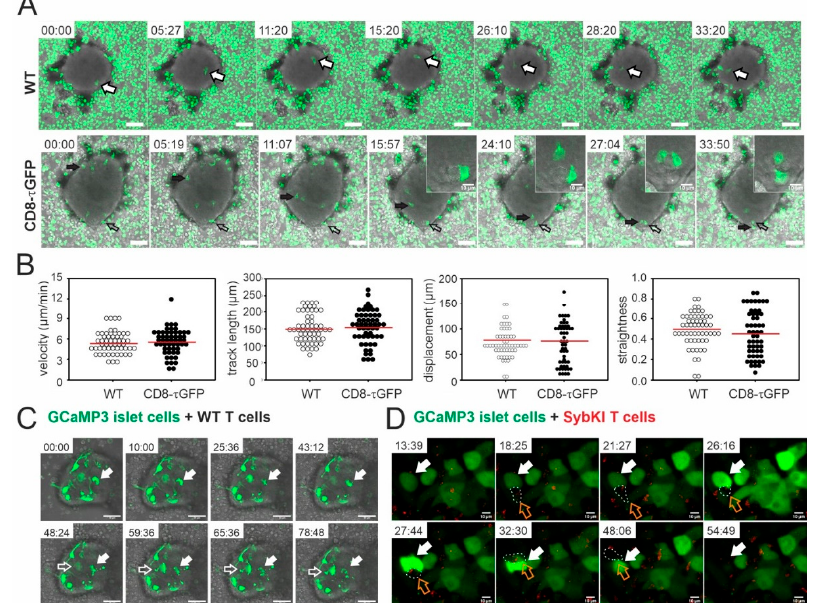
Figure 1. Confocal live imaging of CTLs infiltrating and killing pancreatic islet cells in vitro. ( A ) Confocal snapshots from live images of calcein-loaded WT and CD8- 𝜏 GFP CTLs (green) infiltrating an islet. Arrows point to individual CTLs. Scale bar: 50 µm. Inset shows a CTL (open arrow in overview) in contact with an islet cell. The images were acquired in 9 µm slices with 1 µm interval distance and ~0.3 Hz acquisition frequency. The entire recording is shown in Movies S1 and S2. ( B ) Quantitative analysis of velocity, track length, displacement and straightness of WT and CD8- 𝜏 GFP CTLs on DBA/2-derived islets of Langerhans. ( C ) Confocal snapshots from live images of WT CTLs co-cultured with islet cells which were infected with AV-GCaMP3 (green). Arrows point to apoptotic islet cells whose death can be followed in Movie S3. Scale bar: 50 µm. The images were acquired in 12 µm slices with 2 µm interval distance and ~0.2 Hz acquisition frequency. ( D ) Confocal snapshots from live images of SybKI CTLs (red) co-cultured with islet cells which were infected with AV-GCaMP3 (green). The white arrows point to an islet cell that showed a rapid increase in intracellular calcium concentration after contact with a single CTL (orange arrows). Scale bar: 50 µm. The images were acquired in 5 µm slices with 1 µm interval distance and ~0.1 Hz acquisition frequency. Maximum intensity projections are shown.